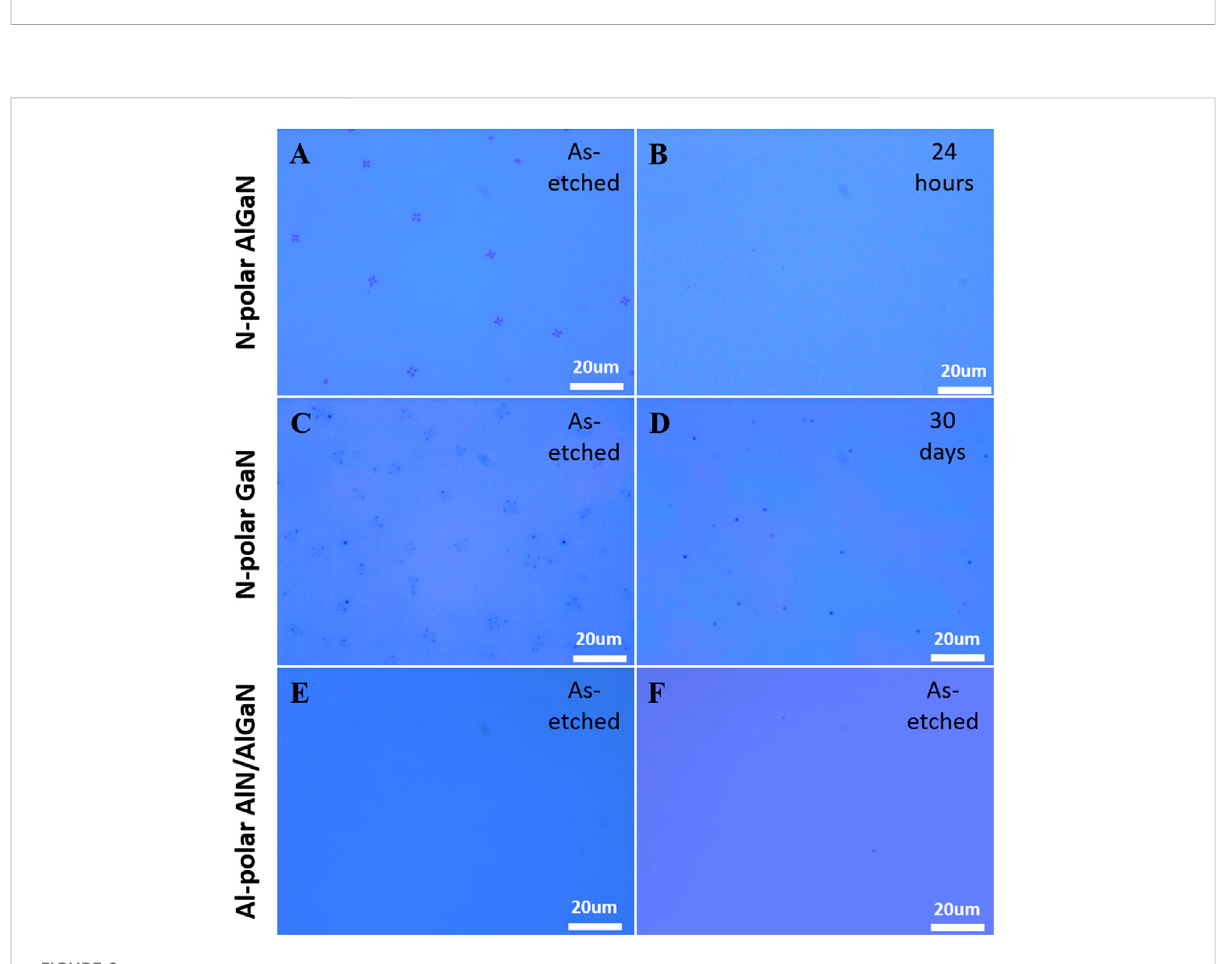
FIGURE 2 OMimagesoftheN-polarAlGaNsurfaceas-etched (A) andafterplacinginairfor1day (B) ,theN-polarGaNsurfaceas-etched (C) andplacingin air after 30 days (D) , and the as-etched Al-polar AlN surface (E) and the as-etched Al-polar AlGaN surface (F)